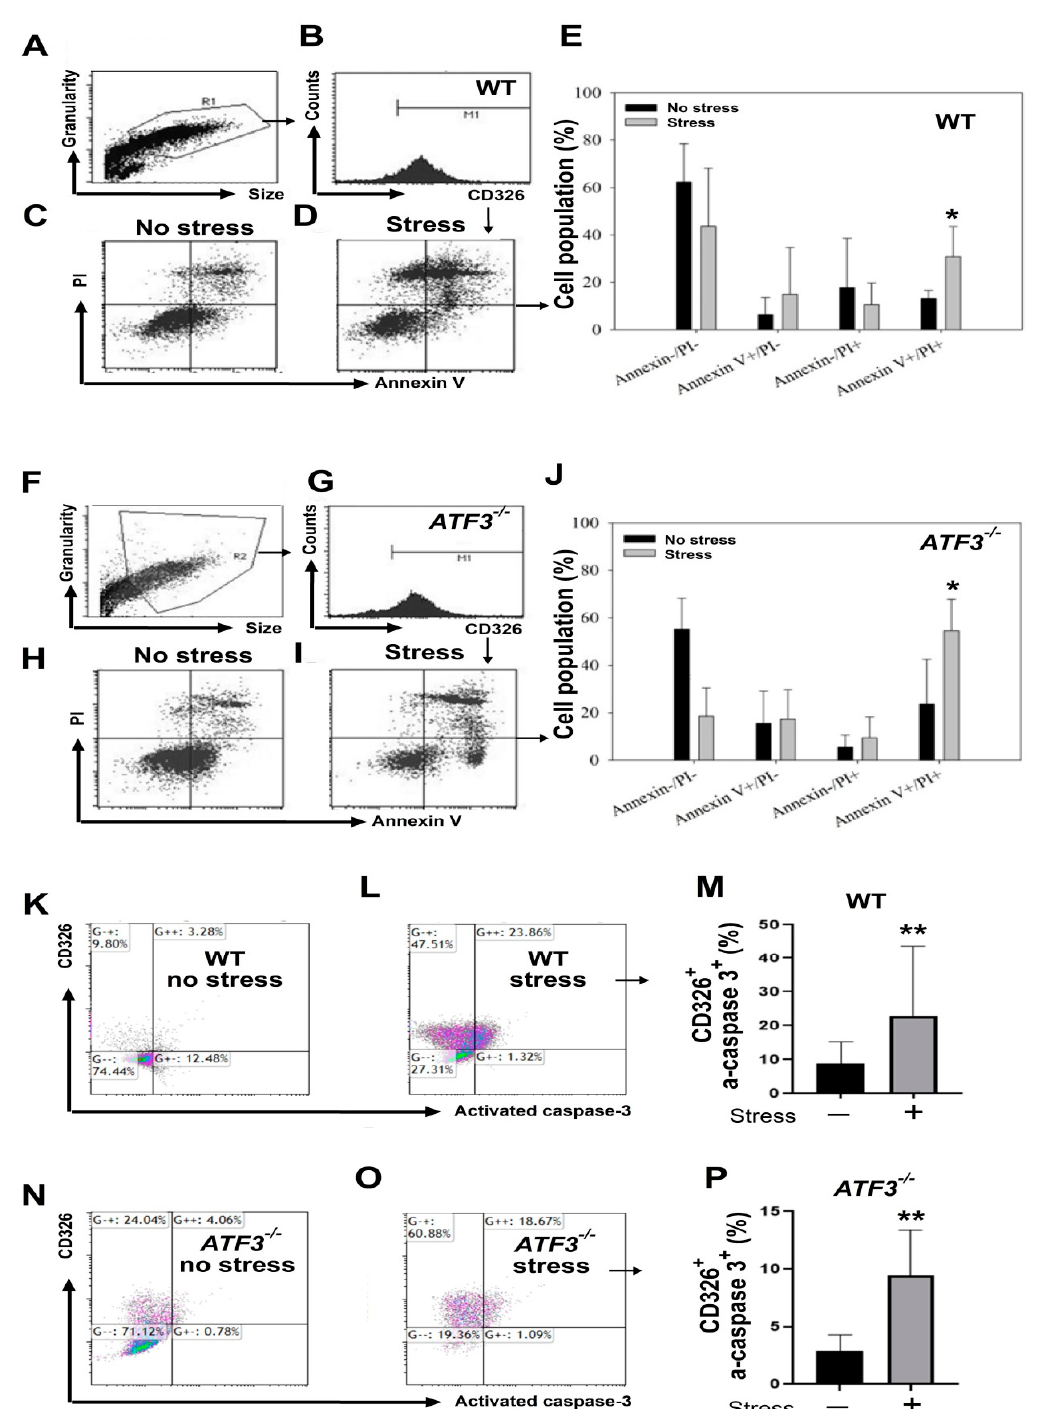
Figure 8. Flow cytometry results of restraint stress-induced GI cell death. ( A – E ) Analyses of WT mouse samples. The gating ( A , B ) and analysis ( C , D ) of CD326 + /PI + /annexin V + dead duodenal epithelial cells from mice without ( C ) or with ( D ) restraint stress, and the quantitative results ( E ) are revealed. ( F – J ) Analyses of the ATF3 − / − mouse samples. The gating ( F , G ) and analysis ( H , I ) of CD326 + /PI + /annexin V + dead duodenal epithelial cells from mice without ( H ) or with ( I ) restraint stress, and the quantitative results ( J ) are indicated. ( K – P ) Relative levels of CD326 + /activated-form caspase-3 + (a-caspase 3 + ) apoptotic epithelial cells in WT ( K – M ) and ATF3 − / − ( N – P ) mice with or without stress are revealed (gating in ( K , L , N , O )). ( M , P ) The quantitative results are indicated. n = 5 (2 experiments with a total of 5 mice per group). ( E , J , M , P ) * p < 0.05 and ** p < 0.01 vs. their respective no stress control groups. Error bars show the standard deviation. The “stress − “ indicates no stress control groups and the “stress +” indicates the stressed groups.